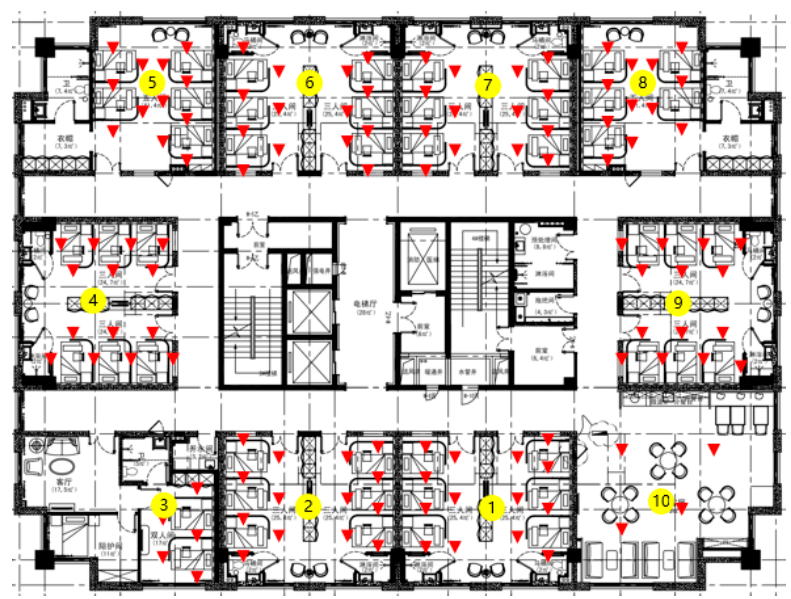
Figure 6. The schematic diagram of the test environment, where the rooms and RPs are labeled with yellow circles and red triangles, respectively.